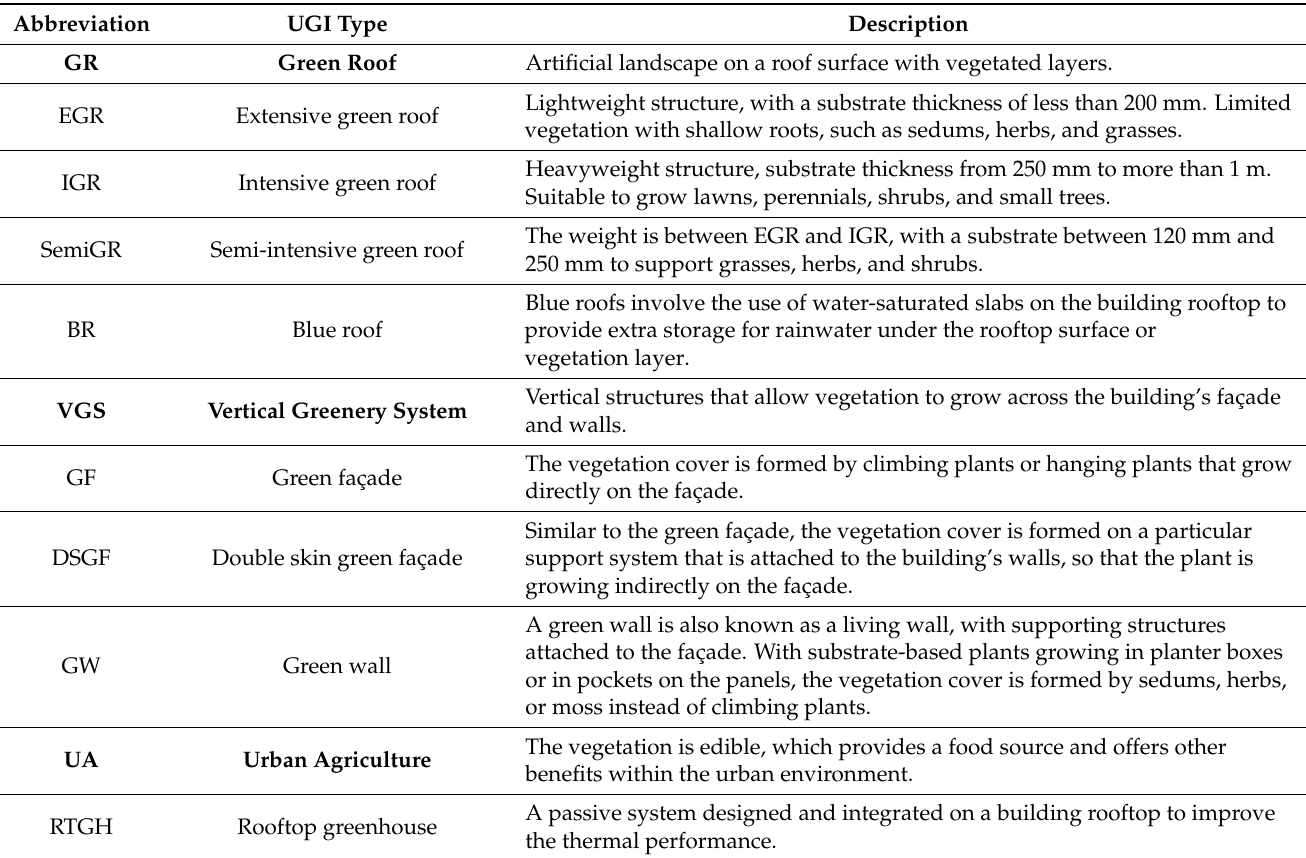
Table 1. Abbreviation for and description of each UGI type investigated in this review